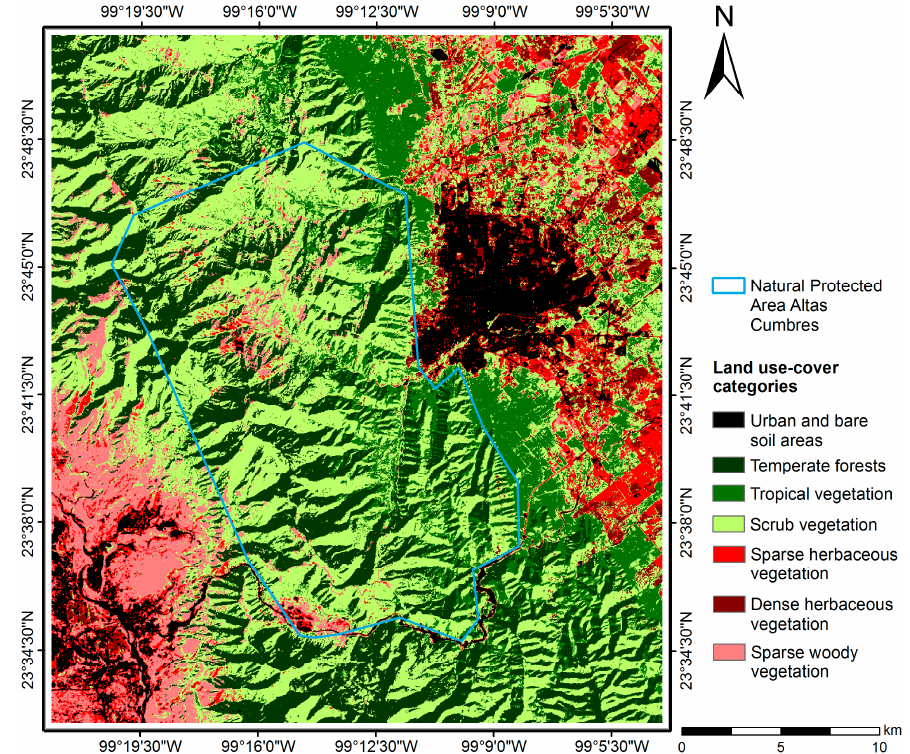
Figure A4. Land use-cover in 2005, Natural Protected Area Altas Cumbres and adjacent area. Victoria, Tamaulipas, Mexico. Remote Sens. 2017 , 9 , 712 27 of 32